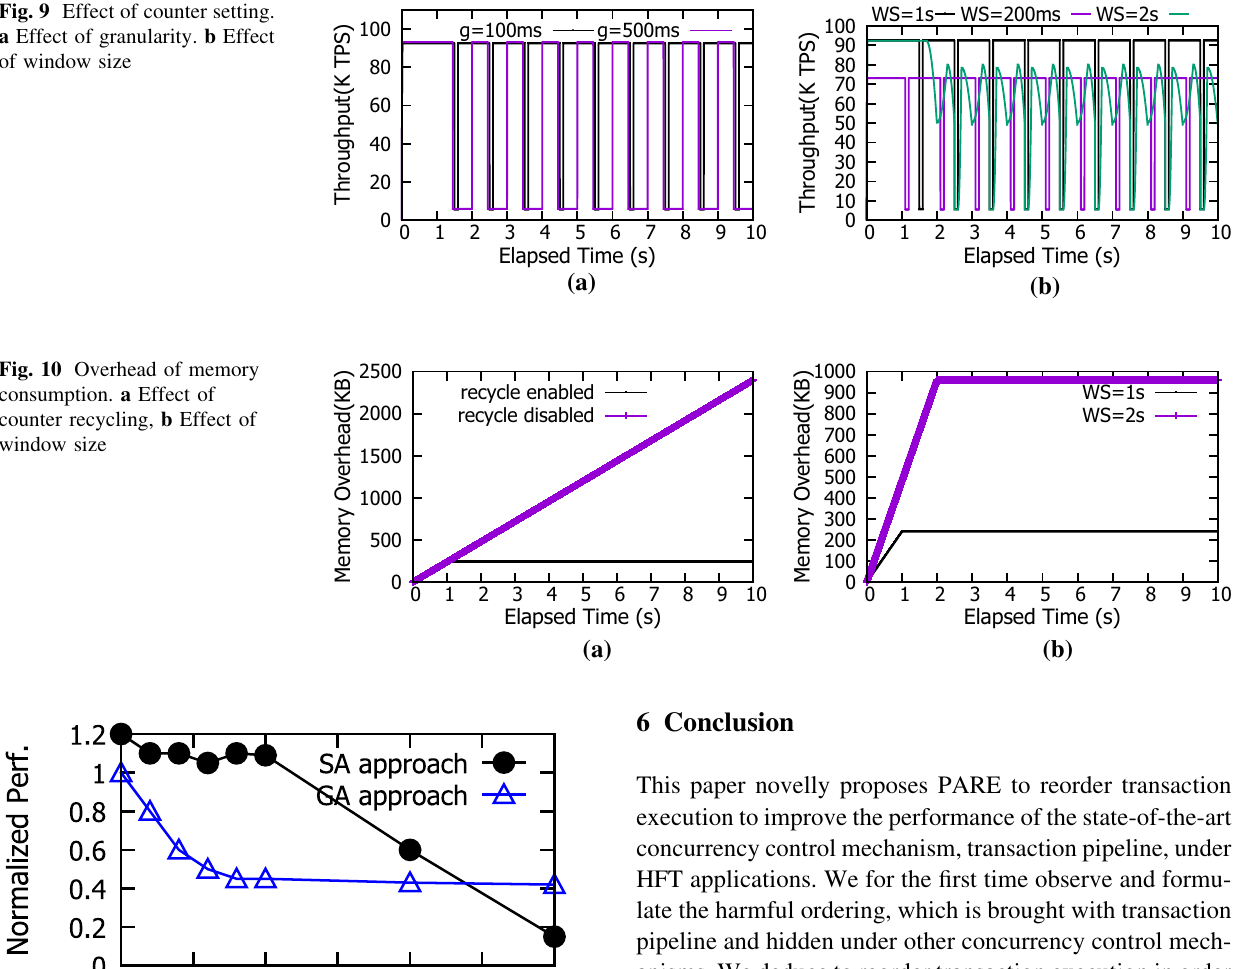
Fig. 9 Effect of counter setting. a Effect of granularity. b Effect of window size